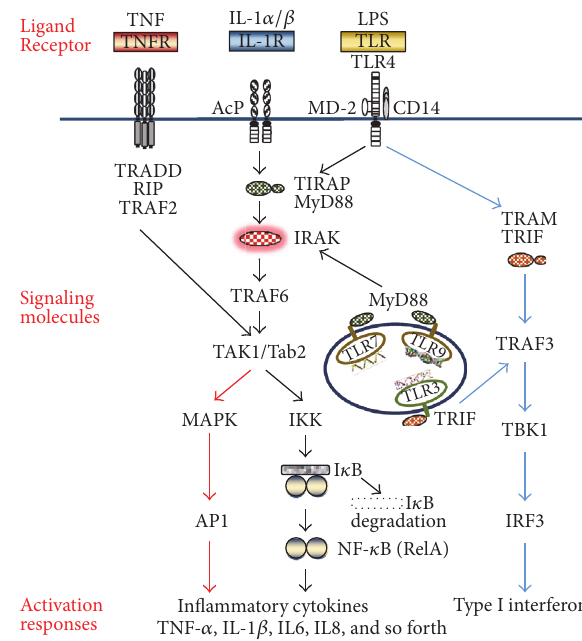
Figure 1: TLR and the related TNFR and IL-1R signaling pathways. TLRs utilize a MYD88 dependent pathway (black line) and a TRIF dependent pathway (blue line) to activate NF- 𝜅 B, AP-1, and IRF3, leading to the production of inflammatory cytokines and type I interferons. IL-1R uses the same set of signaling molecules, and TNFR utilizes the same signaling pathway as TLRs. TLR, toll- like receptor; IL-1R, interleukin-1 receptor; TNFR, tumor necrosis factor receptor; LPS, lipopolysaccharide; TRADD, TNFRSF1A asso- ciated via death domain; TIRAP, TIR domain containing adaptor protein; RIP, receptor interacting serine/threonine kinase; IRAK, interleukin-1 receptor associated kinase; TRAF2, TNF receptor associated factor 2; TRAF3, TNF receptor associated factor 3; TRAF6,TNFreceptorassociatedfactor6; TAK1,TGF-betaactivated kinase 1; MAPK, mitogen-activated protein kinase 1; IKK, I-kappa B kinase; I 𝜅 B, NFKB inhibitor; Tab2, TGF-beta activated kinase 1 binding protein 2; TBK1, TANK-binding kinase 1; MYD88, myeloid differentiation primary response 88; TRIF, TIR domain containing adapter-inducing interferon- 𝛽 ; NF- 𝜅 B, nuclear factor kappa-light- chain-enhancer of activated B cells; AP-1, activator protein 1; IRF3, interferon regulatory factor